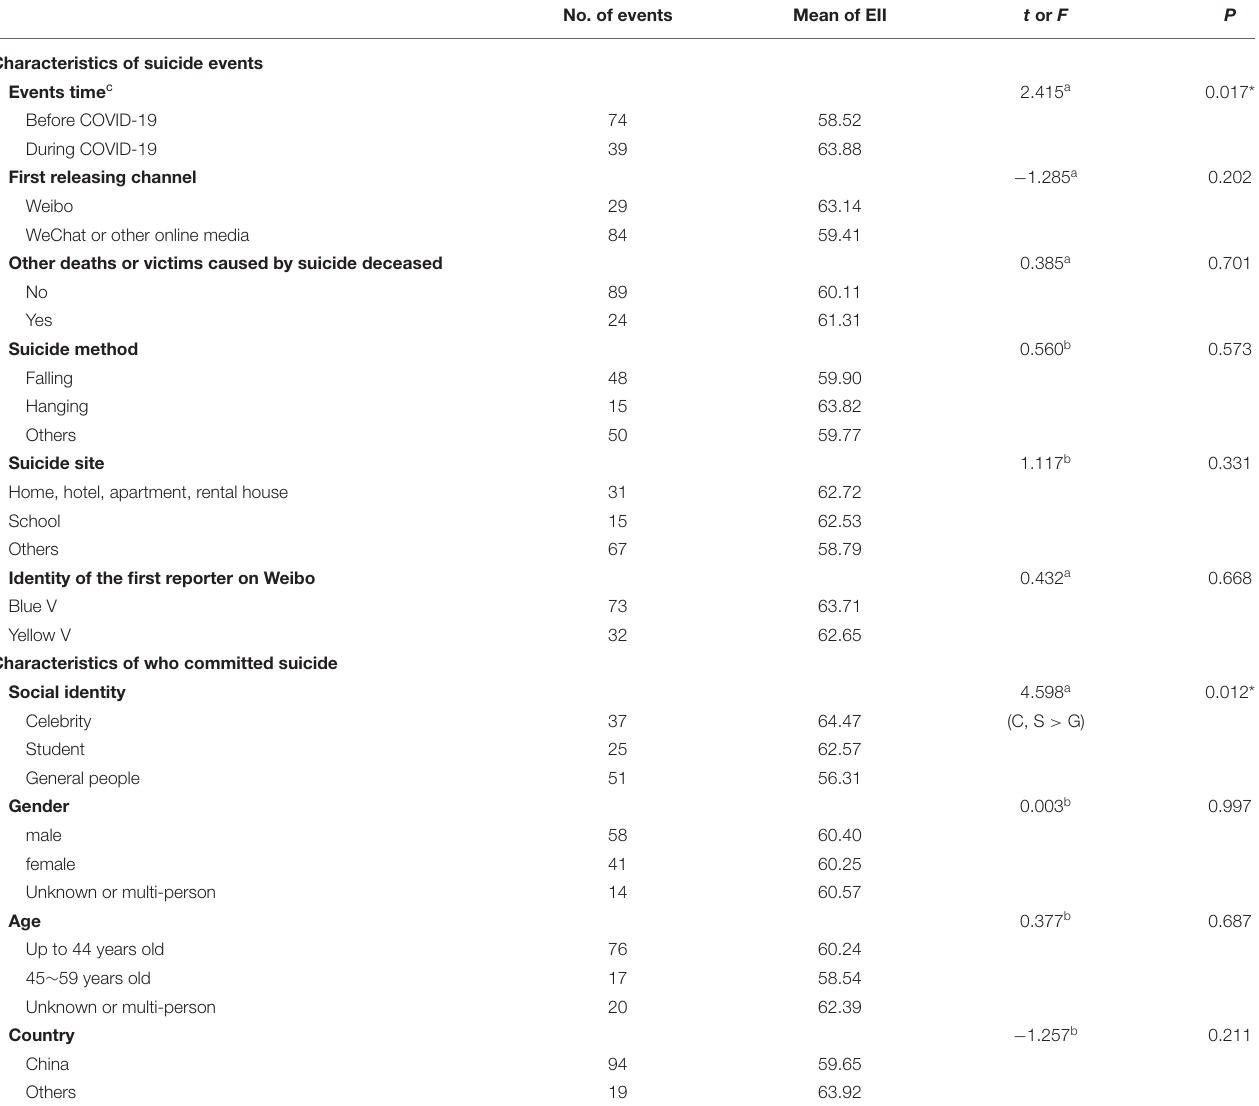
TABLE 1 | Relationship between characteristics and EII of suicide reports on the internet (n 1 = 113 suicide